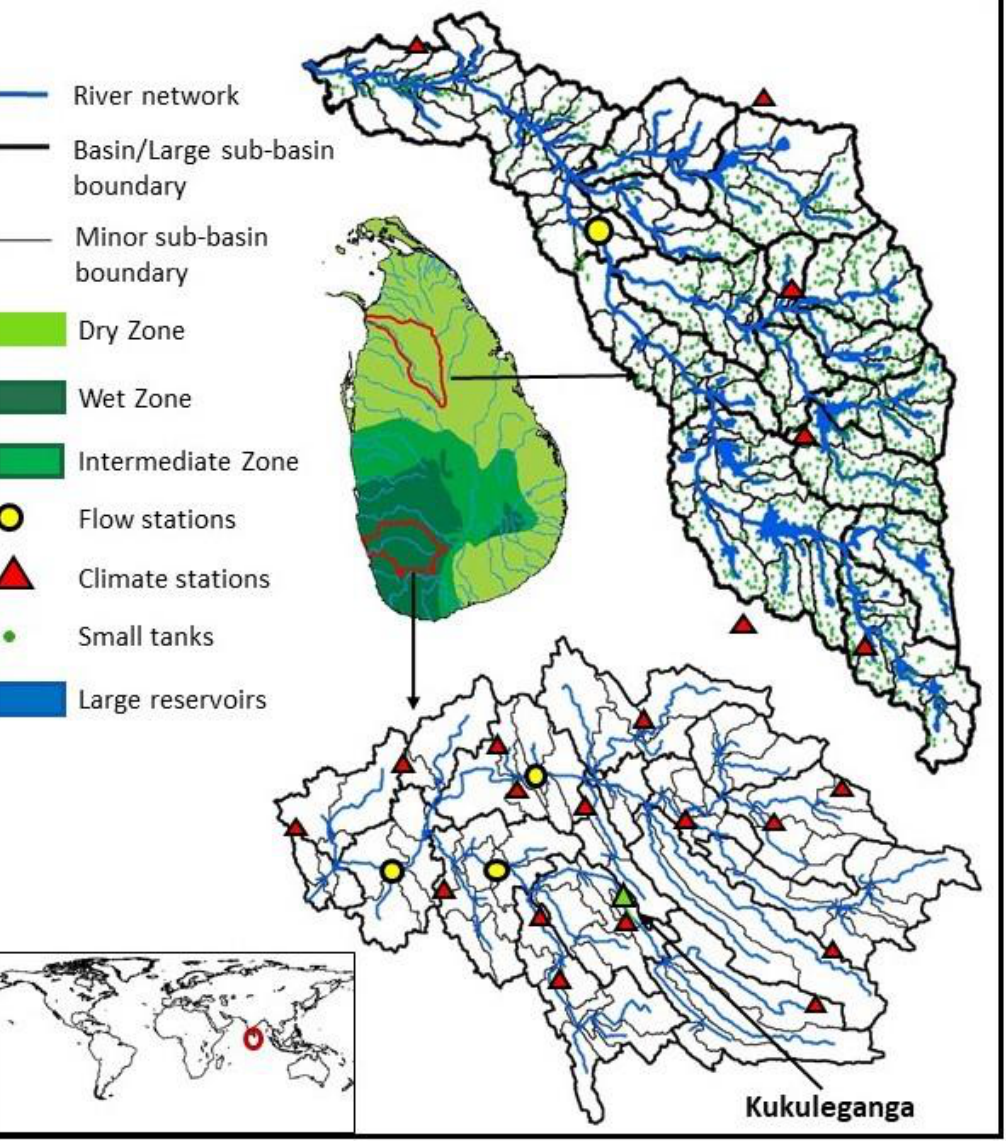
Figure 1. Study basins in climatic zones of Sri Lanka ( center ), the sub-basin structure, and hydrography of the Malwatu Oya ( top ), and the Kalu Ganga ( bottom ) basins.